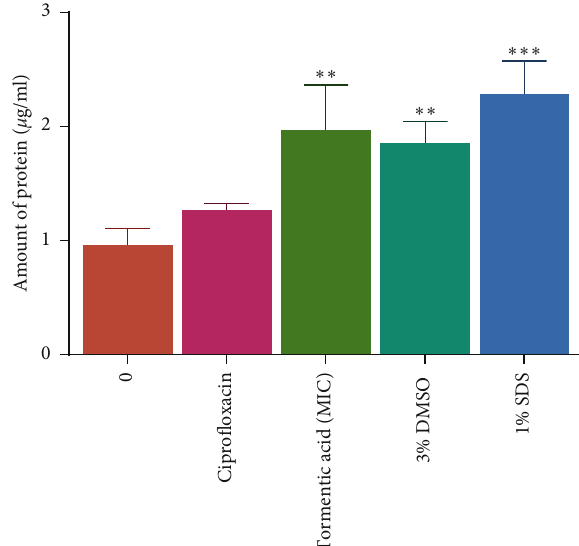
Figure 4: The effect of exposing P aeruginosa to ciprofloxacin (0.016 µ g/ml) and tormentic acid congener (100 µ g/ml) on release of in- tracellular protein in P. aeruginosa . The absorbance intensities of treated P aeruginosa cells were measured at 590nm. Results are presented as mean ( n � 3) ± standard deviations. Asterisk denotes a significant difference ( ∗∗ P <